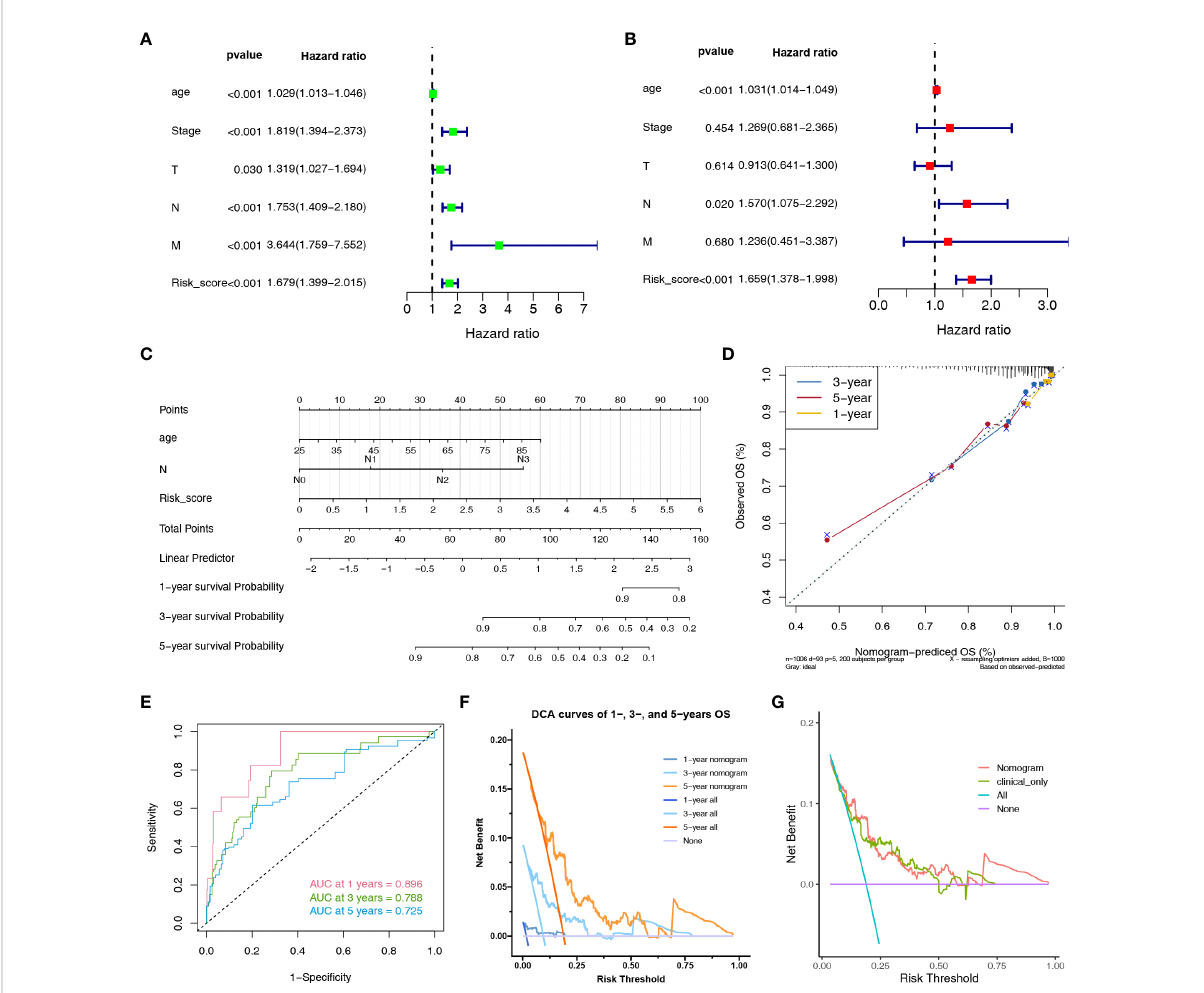
FIGURE 5 Nomogram to evaluate the OS probability of BC patients. The univariate (A) and multivariate (B) Cox regression analyses in TCGA cohort. (C) The nomogram for predicting the 1-, 3- and 5-year OS probabilities. (D) Calibration curves of the nomogram to predict 1-, 3- and 5-year OS probabilities. (E) ROC curves of the nomogram. (F) DCA curves of the nomogram at 1-, 3- and 5-year indicated its net clinical bene fi ts. (G) DCA curves of the nomogram and only clinical characteristics (combination of age and N